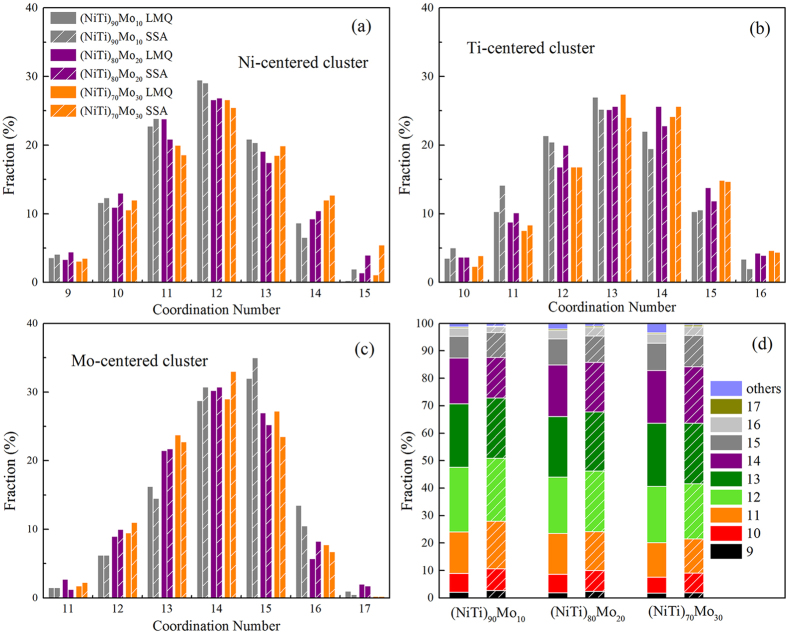
Distributions of the coordination number (CN): (a) Ni-centered, (b) Ti-centered, (c) Mo-centered, and (d) total of (NiTi)90Mo10, (NiTi)80Mo20, and (NiTi)70Mo30 MGs obtained by LMQ and SSA.